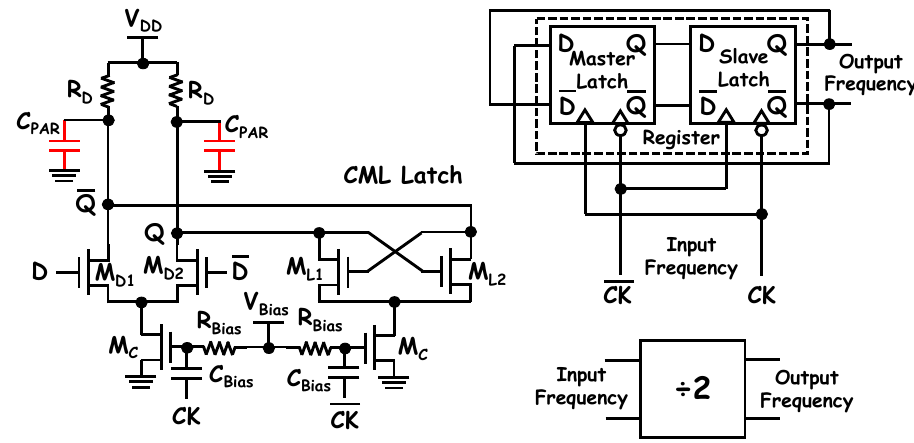
Figure 7. Divide-by-two Frequency Divider.